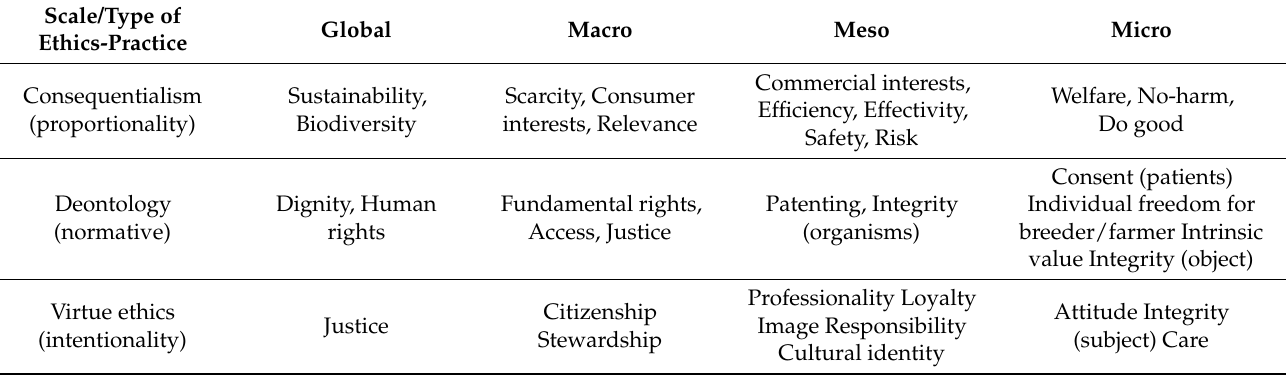
Table 1. Levels and styles of ethics (adapted from